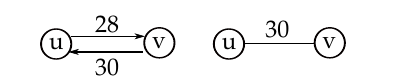
Figure 5. Undirectional assignment of